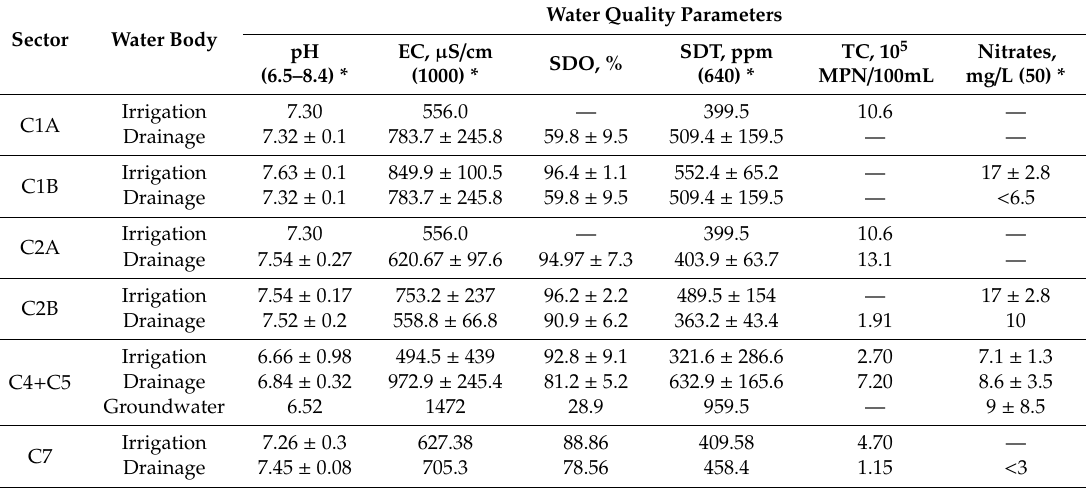
Table 4. Physicochemical and microbiological parameters of water sampled per sector and water body in 2018 (average ± standard